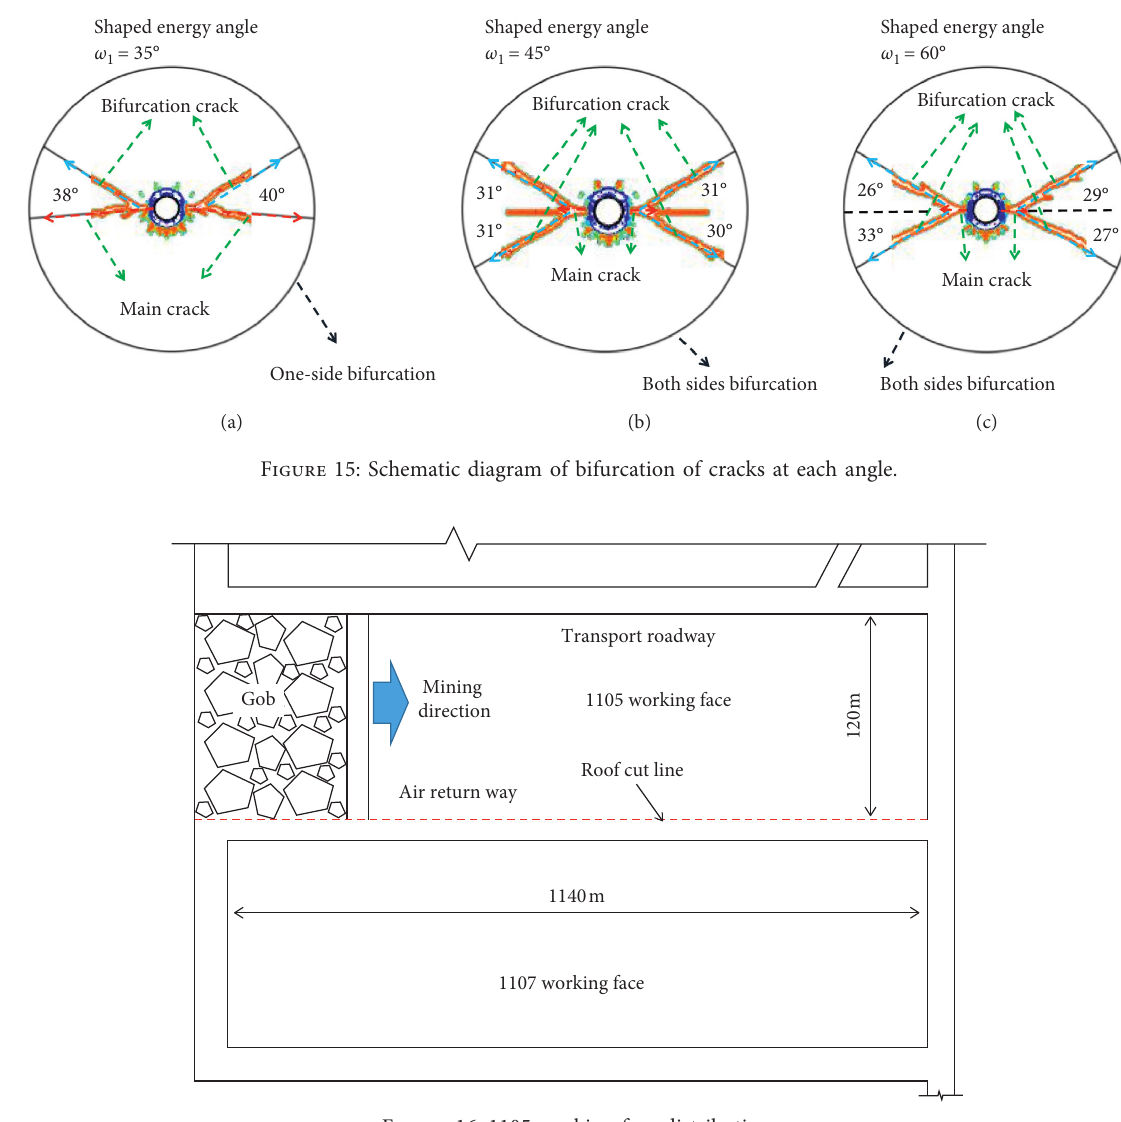
Figure 16: 1105 working face distribution.